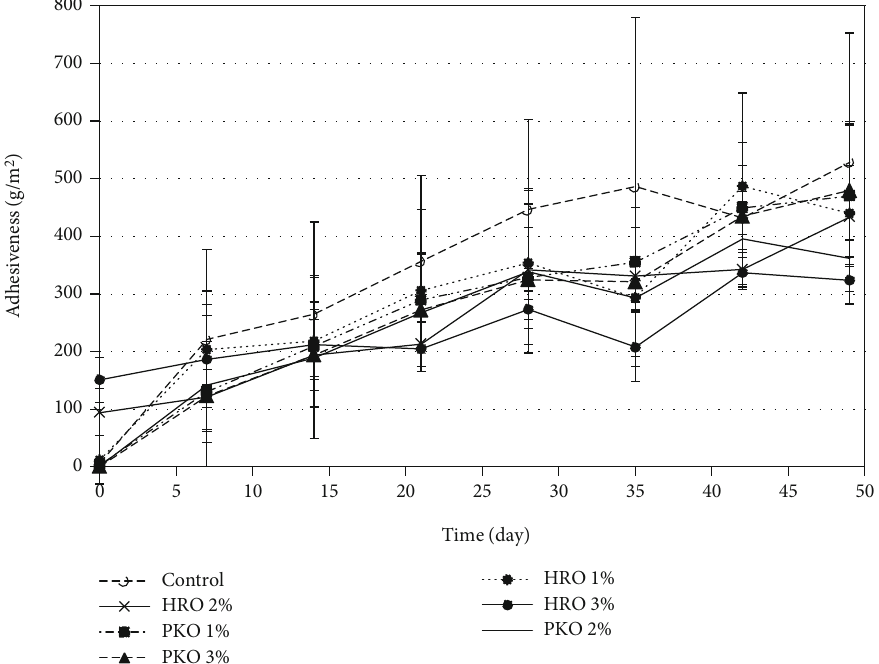
Figure 4: The e ffi cacies of HRO and PKO on the adhesiveness of the seed